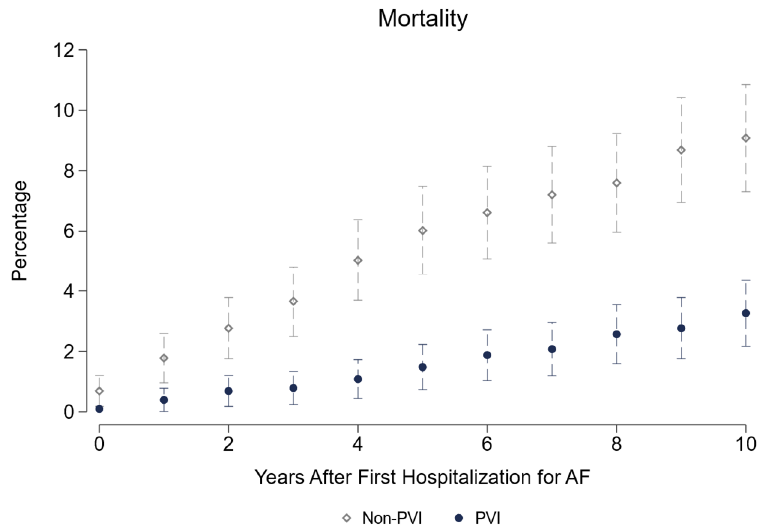
Figure 2. Long-term healthcare Expenditure and Hospital days. Table 3. Long-term Outcomes ten years after first hospitalization for atrial